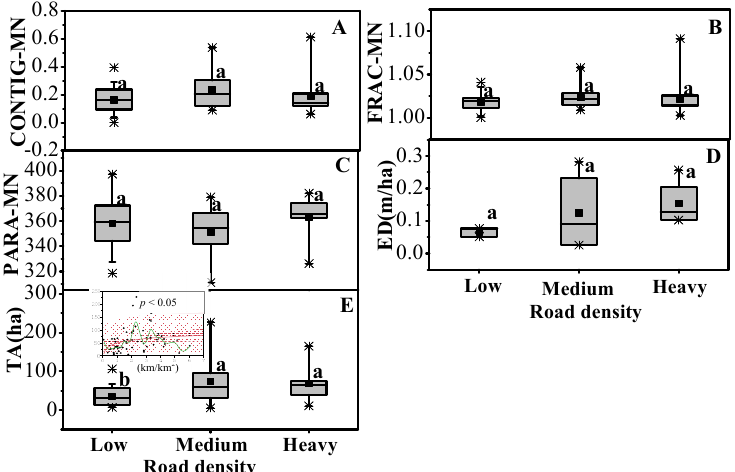
Figure 3. Area-edge and shape metric changes in urban forests across different road densities (RD). ( A ) area-weighted mean contiguity index (CONTIG-MN), ( B ) mean fractal dimension index (FRAC-MN), ( C ) mean perimeter area ratio (PARA-MN), ( D ) edge density (ED), and ( E ) total area (TA). Boxplots show the mean (black square), median (black line in the box), inter-quartile range (25%–75% in the box), and the range of normal values (the whisker). Mean values sharing different letters are significantly different ( p < 0.05), and mean values sharing the same letters are not significantly different ( p > 0.05). Figure insets depict significant regression lines from the raw data. The red line represents the regression line, and the green lines represent the moving mean value. The dual-shaded shadows represent the best-fitting and predicted interval